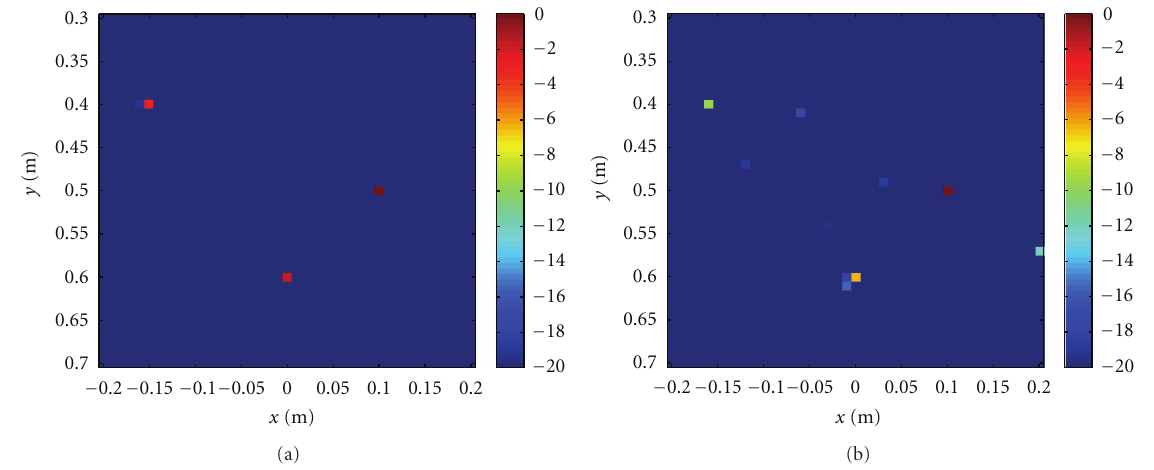
Figure 4: CS imaging results under di ff erent noise levels (a) SNR = 5 dB; (b) SNR = − 5 dB.